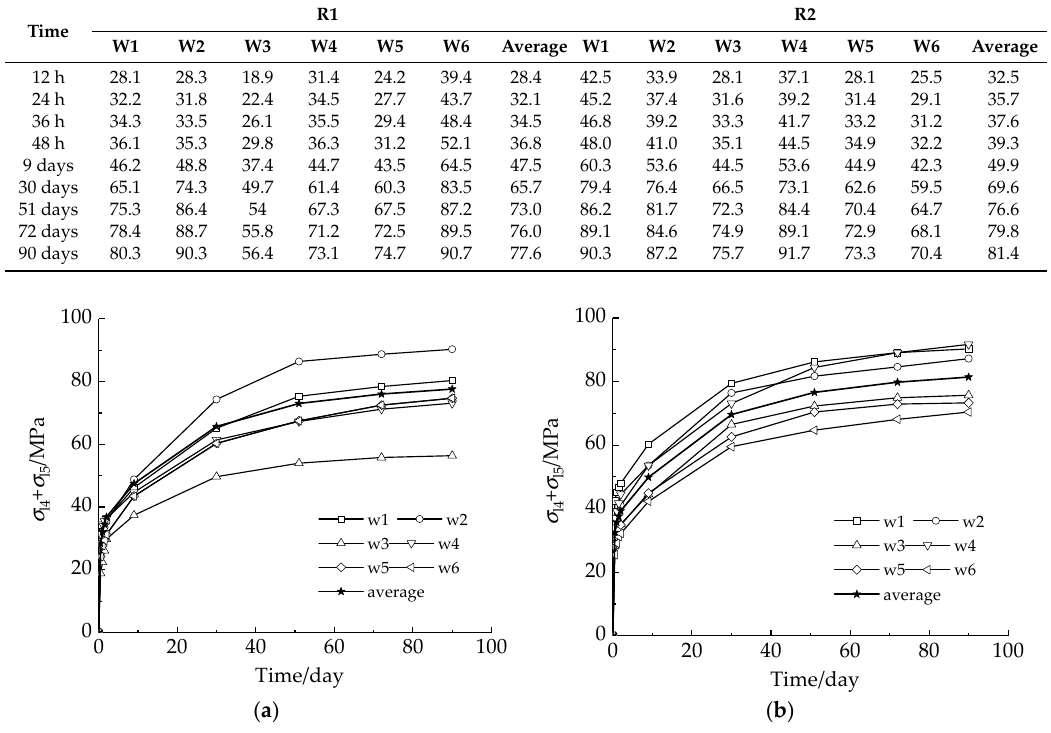
Table 13 records the strain reductions of W1–W6 due to steel relaxation of strands and creep of concrete in 90 days after anchoring. The calculated sum of the prestress losses, σ l4 and σ l5 , is listed in Table 14 and illustrated in Figure 12. Table 14. The sum of σ l4 and σ l5 calculated from the strains obtained from the LFBG sensors. (Units: MPa). Time